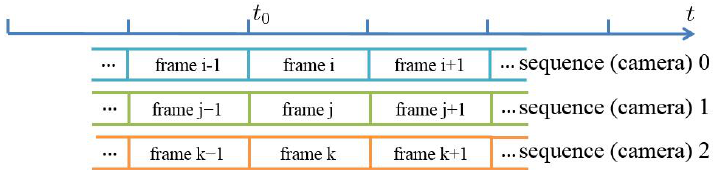
Figure 11. Sequence match. The frames from three video sequences are aligned. The sequence match process is to determine the values of i, j and k.